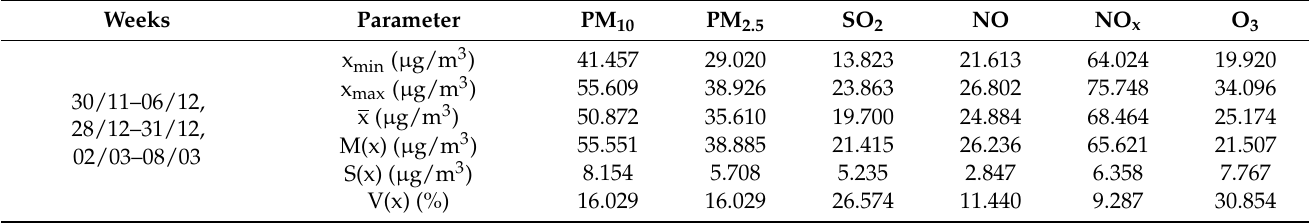
Table 5. Average measures and measures of relative variability for group no. 2.